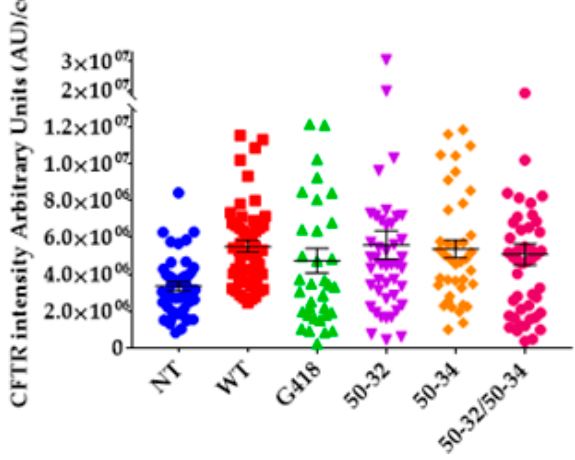
Figure 7. Immunofluorescence analysis of CFTR protein in triton permeabilized FRT-CFTR W1282X cells and quantification of the immunofluorescence. FRT-CFTR W1282X cells were transfected with the plasmids encoding the indicated g RNAs and dCAS13b / ADAR2 DD (300 ng total DNA). Untransfected FRT-CFTR W1282X cells (NT) were used as negative control. FRT-CFTR W1282X cells treated with G418 and FRT-CFTR WT cells were used as a positive control. ( A ) The CFTR protein was revealed by the primary antibody mAb570, followed by a secondary antibody anti-mouse-FITC conjugated (green, Sigma). Nuclei (blue) were DAPI stained. Images were taken at 63x magnification on a ZEISS microscope equipped for epifluorescence. ( B ) The quantification is relative to the replicate representative of the results. The error bar represents the standard error of the mean (SEM). The quantification of CFTR signal was done manually by using Fiji software. The cell contour was drawn by using a cell membrane marker. The background was subtracted and the integrated signal intensity in the selected area (one cell) was measured.